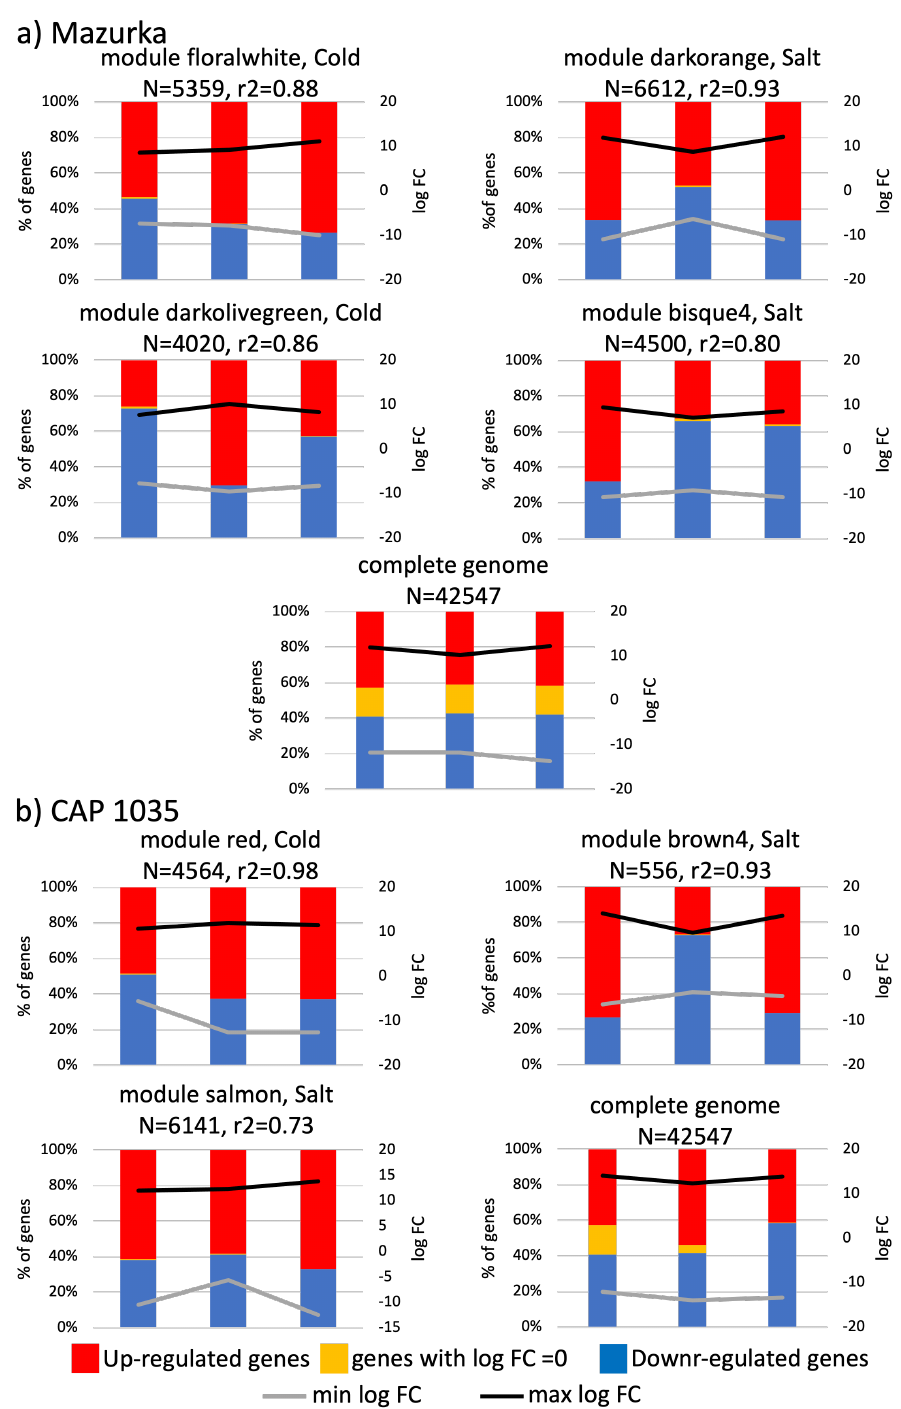
Figure A9. Characteristics of modules from the transcriptome with a high correlation for one binary trait shown for Mazurka ( a ) and CAP1035 ( b ) at d7. RNASeq data was used to perform a WGCNA . Modules with a correlation of 0.73 and higher were investigated for the presence of up- (red) or down-regulated (blue) genes. Genes having a log 2 FC = 0 are indicated in yellow. The absolute maximal log 2 FC (black line) and minimal log 2 FC (grey line) are indicated. Beneath the module name the number of genes within the module is shown. The graph on the bottom shows data for the whole genome.